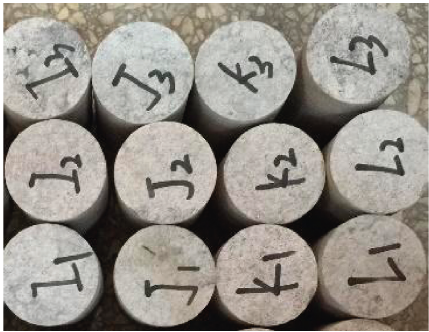
Figure 1: Sandstone